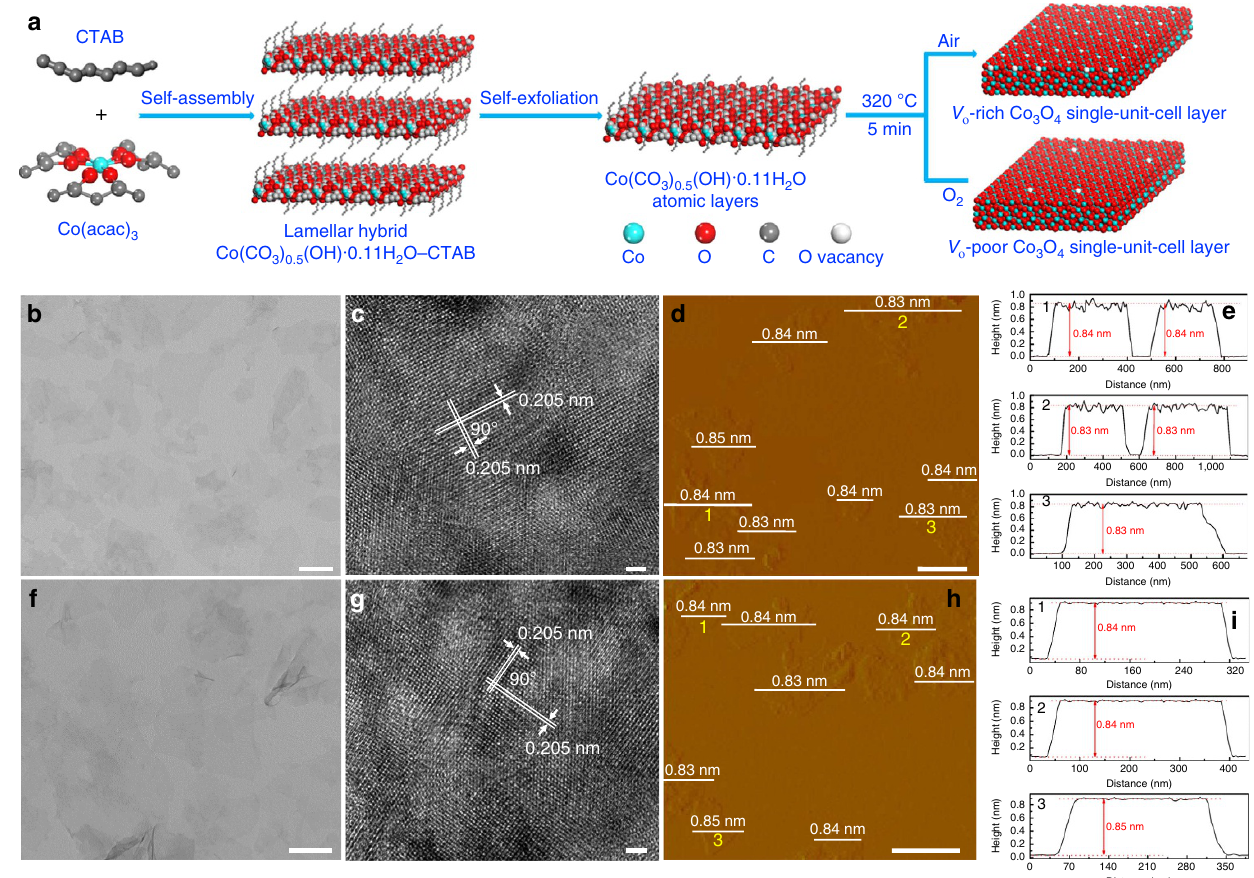
Figure 1 | Preparation and characterization for the V o -rich and V o -poor Co 3 O 4 single-unit-cell layer. ( a ) Scheme for the formation of V o -rich and V o -poor Co 3 O 4 single-unit-cell layer, respectively. Characterization for the V o -rich Co 3 O 4 single-unit-cell layer: ( b ) TEM image, ( c ) HRTEM image, ( d ) AFM image and ( e ) the corresponding height profiles; the numbers from 1 to 3 in d correspond to the numbers from 1 to 3 in e . Characterization for the V o -poor Co 3 O 4 single-unit-cell layer: ( f ) TEM image, ( g ) HRTEM image. ( h ) AFM image and ( i ) the corresponding height profiles; the numbers from 1 to 3 in i corresponding to the numbers from 1 to 3 in h . The scale bars in b – d and f – h are 250, 1, 500, 200, 1 and 500nm, respectively.